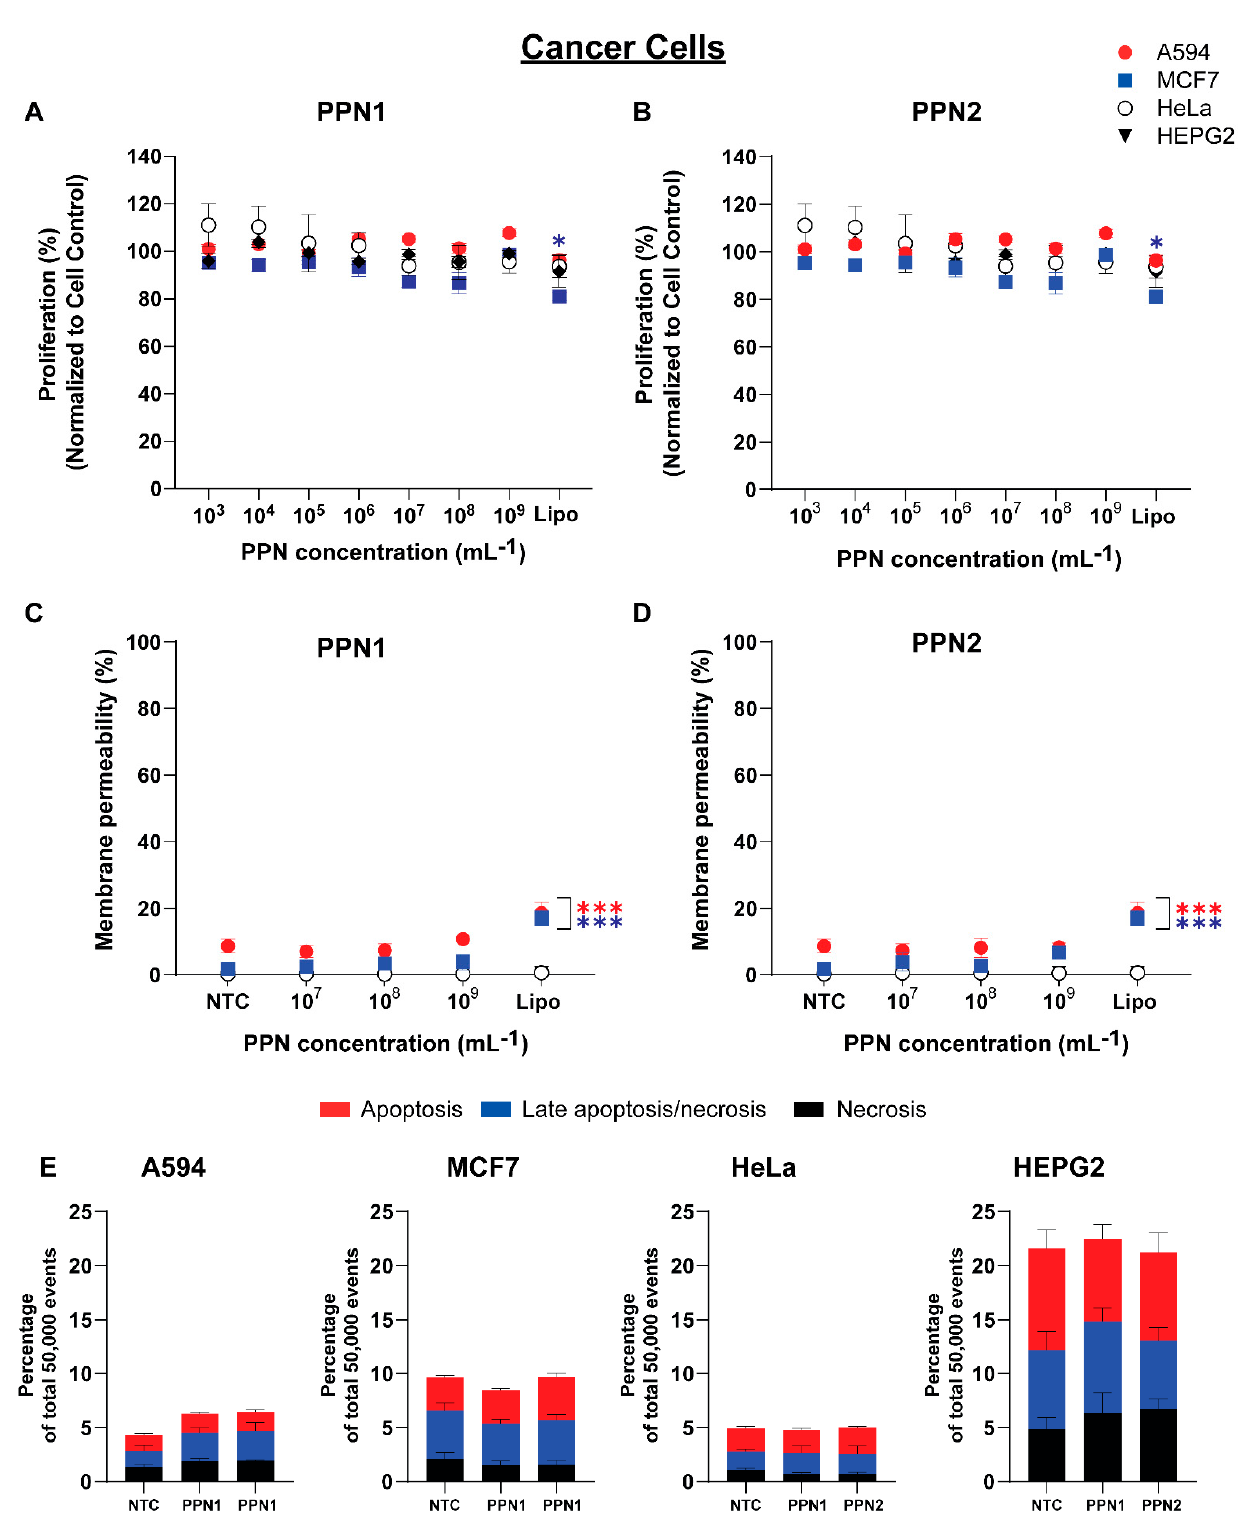
Figure 3. The effects of the size (PPN1 and PPN2) and dose of the PPNs (concentration ranging from 10 3 to 10 9 PPN/mL on ( A , B ) cell proliferation, ( C , D ) cell membrane integrity, and ( E ) apoptosis in cancer cells (A594, MCF7, HeLa, and HEPG2). Untreated cells and cells treated with lipofectamine were used as control groups. The data represent the mean ± standard deviation ( n = 4). Statistical significance was determined using Tukey’s multiple comparison test (*** and * represent p < 0.001 and p < 0.05).